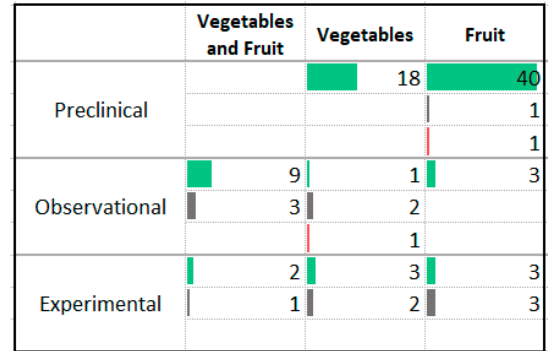
Figure 12. Studies assessing vegetables and/or fruit and anxiety. █ Higher intake or levels associ- ated with decreased anxiety. █ No association between intake or levels and anxiety. █ Higher intake or levels associated with increased anxiety. with decreased anxiety. (cid:110) No association between intake or levels and anxiety. (cid:110) Higher intake or levels associated with increased